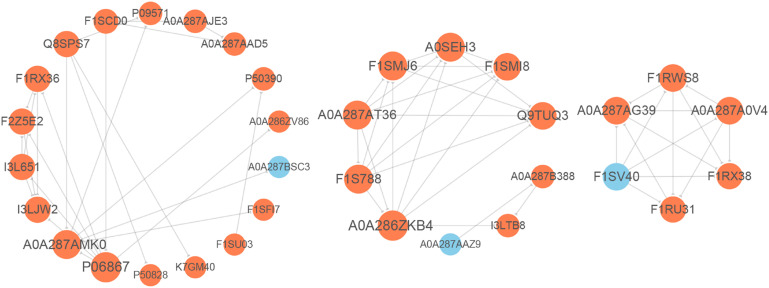
Protein–protein interaction (PPI) network analysis of differentially expressed proteins (DEPs). The gray lines represent direct interactions between two proteins. The circles stand for DEPs, orange circles indicate up-regulated proteins, and blue circles indicate down-regulated proteins.